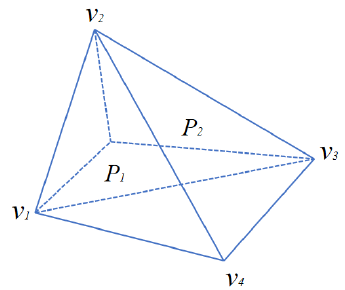
Figure 3. Vertex table pointer representation.